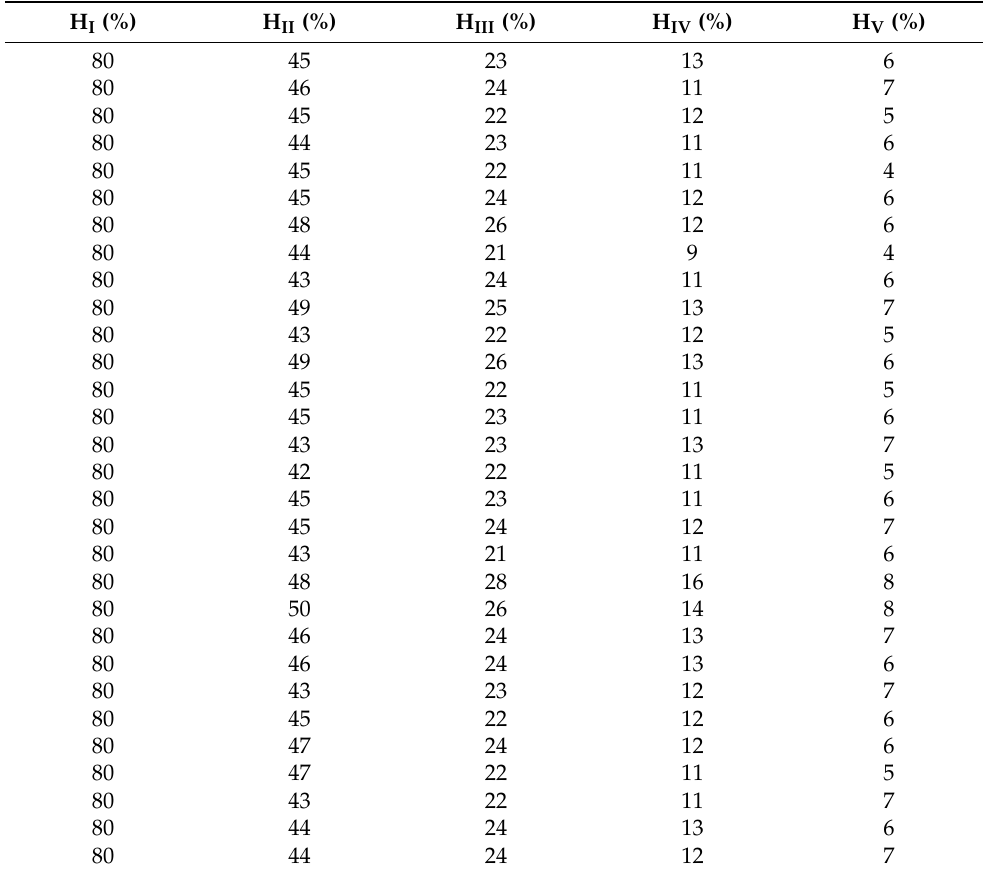
Table A1. The results of ultrasonic measurements used to determine the attenuation in samples produced with the additive